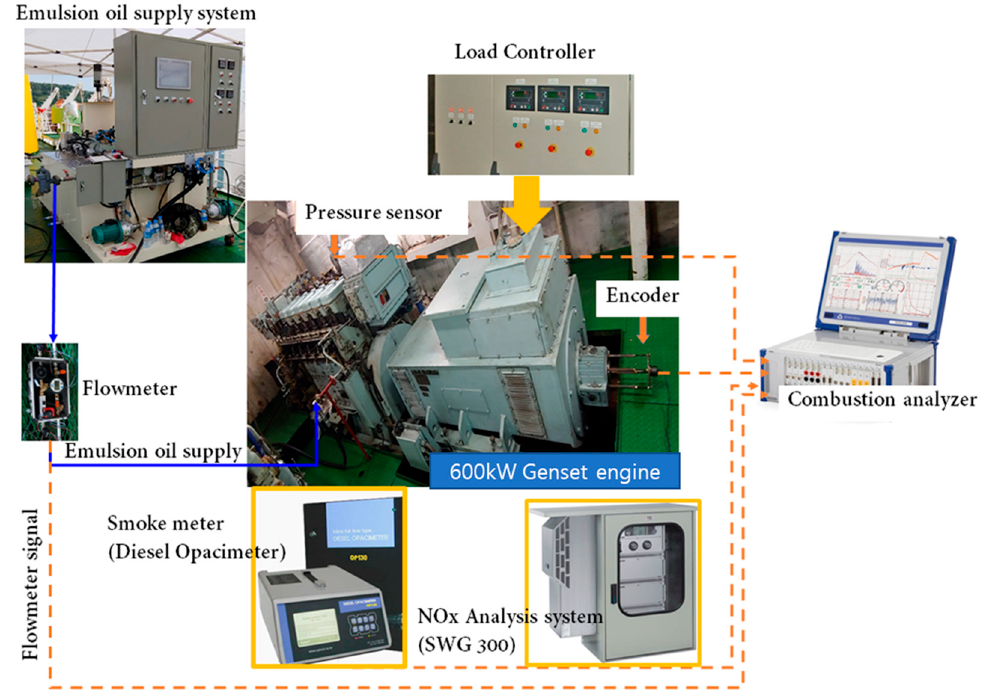
Figure 2. Schematic diagram for four-stroke marine engine.